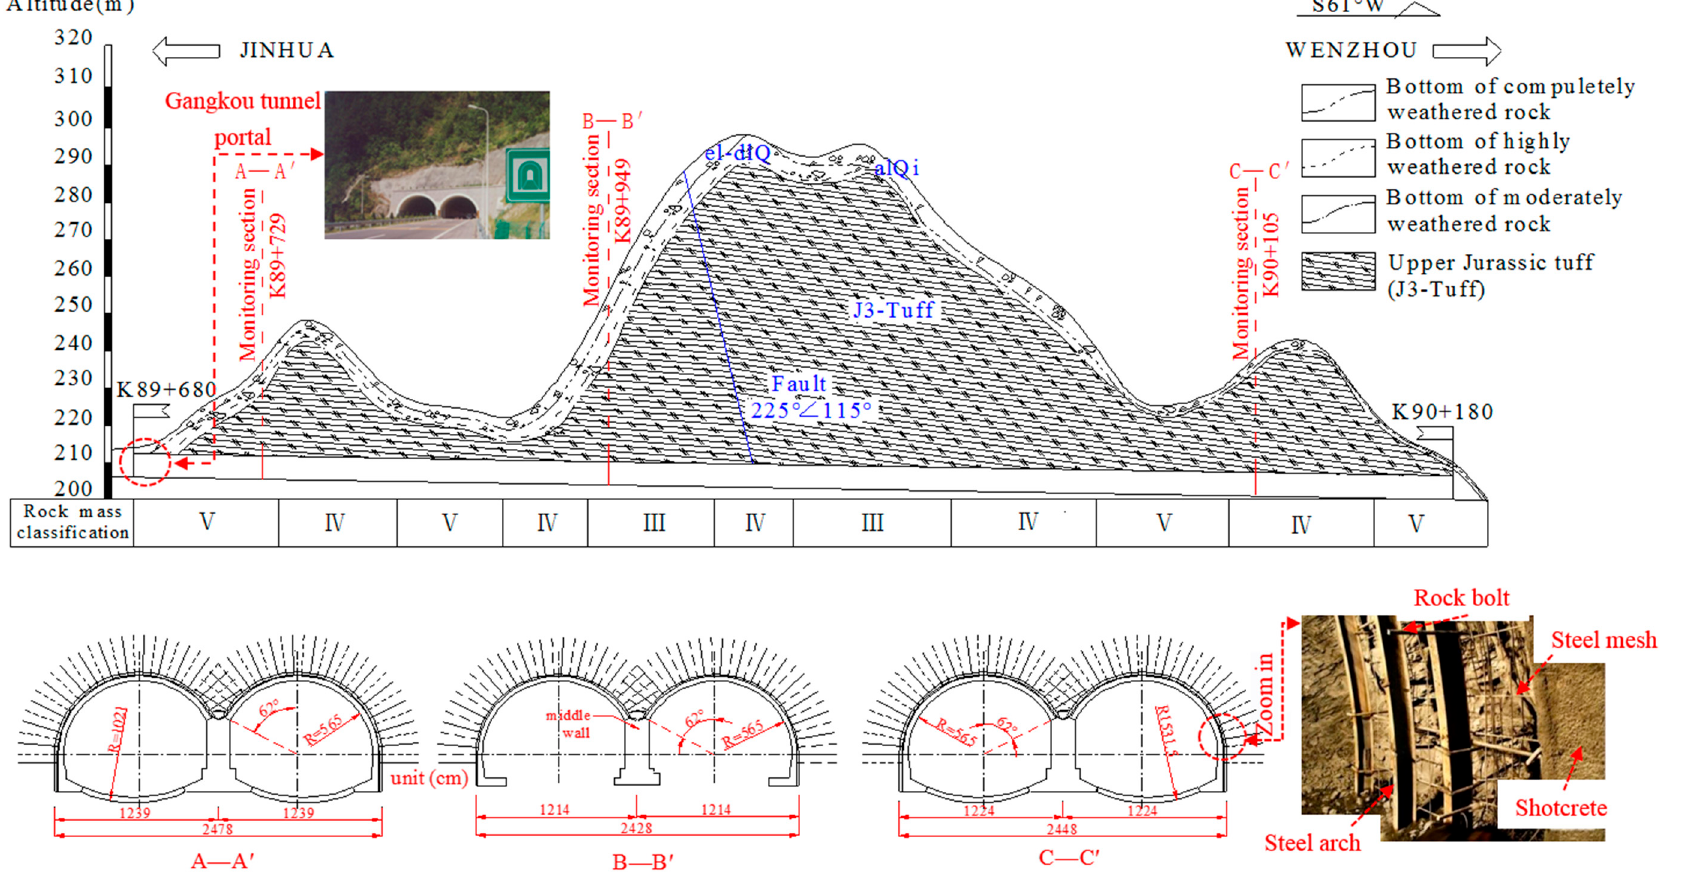
Figure 1. Longitudinal and cross sections of the Gangkou double ‐ arched tunnel.